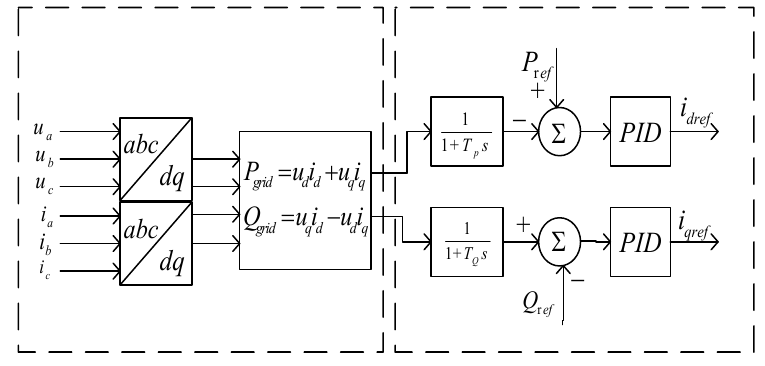
Figure 10. Typical structure of constant power outer loop controller.